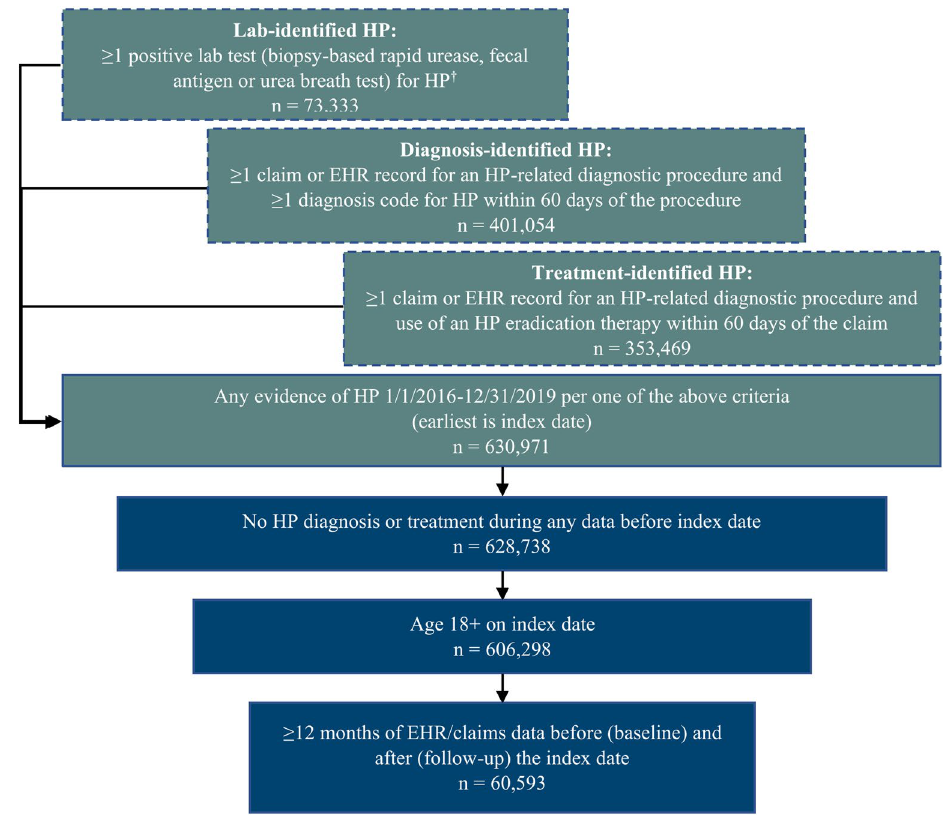
Figure 1. Patient selection criteria and resulting sample sizes. HP, Helicobacter pylori ; EHR, electronic health record. † Serology tests were not included as they are not used to confirm active HP